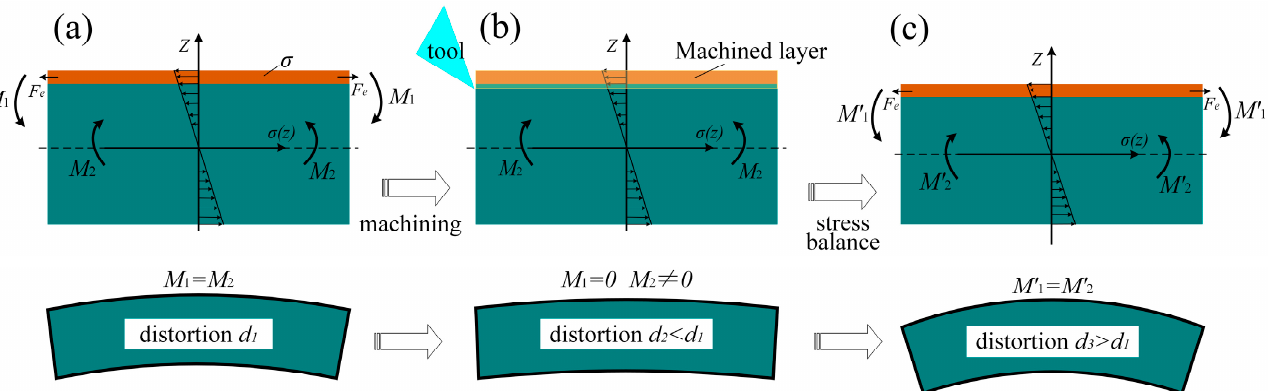
Figure 9. Distortion caused by multiple manufacturing sequences. ( a ) first machining distortion; ( b ) multiple machining; ( c ) last machining distortion.